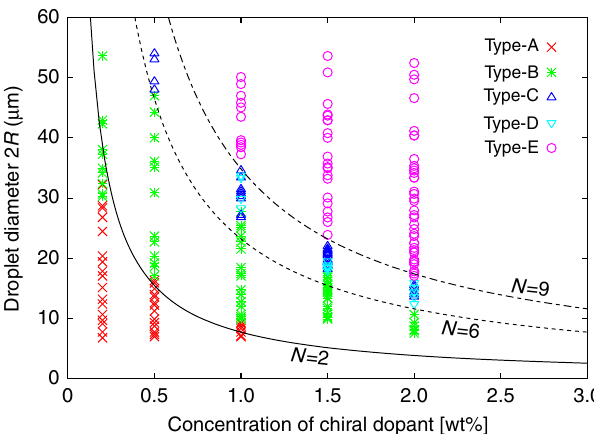
Fig. 2 Phase diagram representing the stability of Type-A through Type-E. The stationary temperature is 60 °C. The three curves are drawn with the function N = 4 R / P 0 for N = 2 (solid line), N = 6 (broken line), and N = 9 (dashed dotted line), which can be approximated to be the boundaries between Type-A and Type-B, Type-B and Type-C/D, and Type-C/D and Type-E,